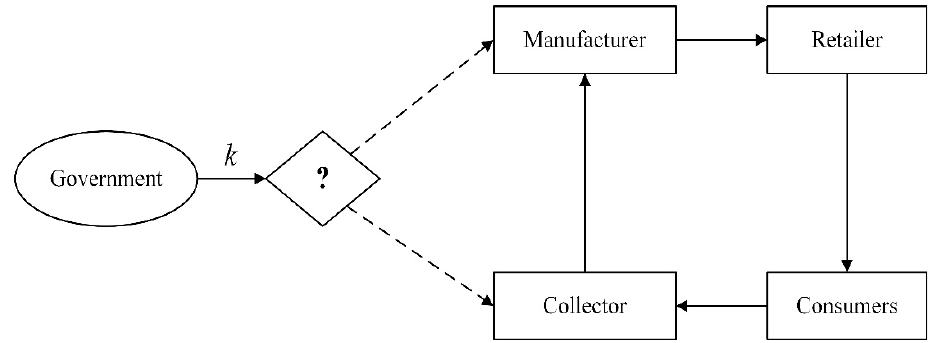
Figure 1. Close ‐ loop supply chain (CLSC) structure under government guidance. Figure 1. Close-loop supply chain (CLSC) structure under government